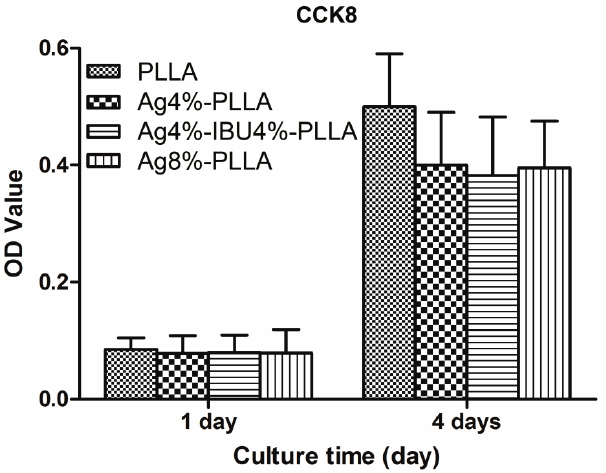
Figure 5. The results of a viability assay of C3H10T1/2 cells (C3) grown on the surface